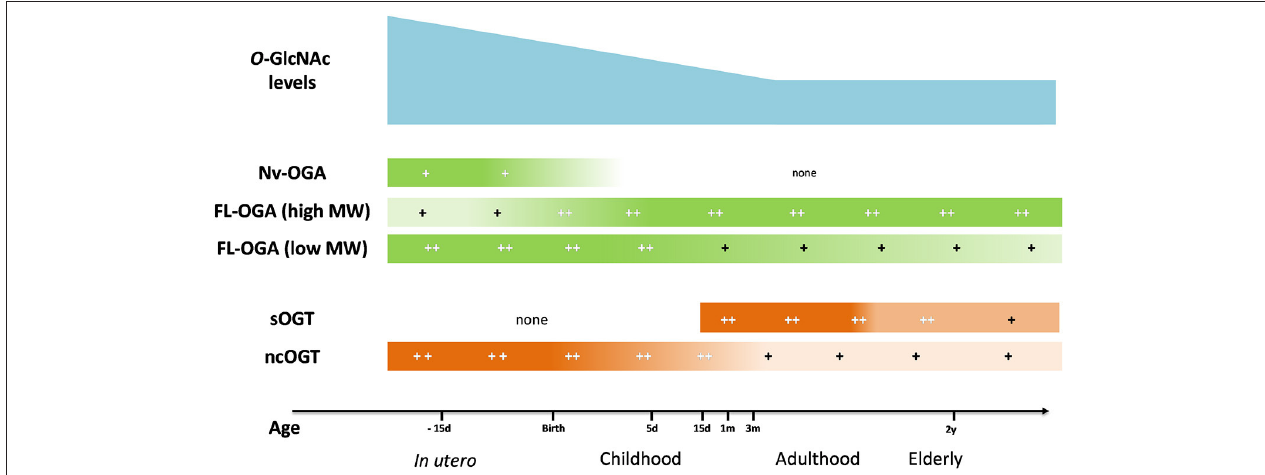
FIGURE 2 | Evolution of O- GlcNAc levels, OGA and OGT expression in brain tissue throughout lifespan. OGA, O- GlcNAcase; OGT, O- GlcNAc transferase; FL-OGA, full-length OGA; high MW, high molecular weight, low MW, low molecular weight; Nv-OGA, Nuclear variant OGA; ncOGT, nucleo - cytoplasmic OGT; sOGT, short OGT; − 15 d, 15 days before birth; 5 d, 5 days post-natal; 15 d, 15 days; 1m, 1 month; 3m, 3 months; 2 y, 2 years (105–107).